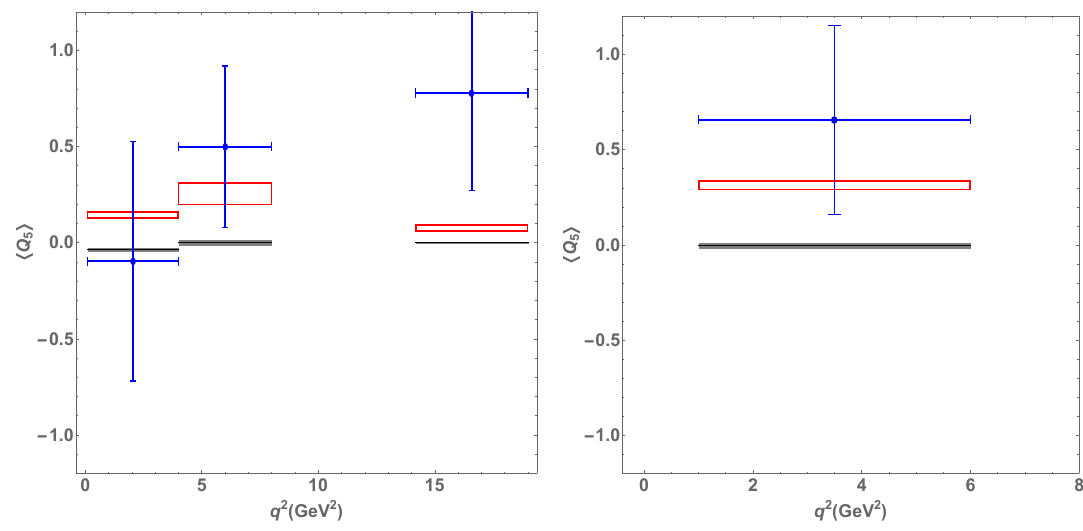
Figure 4 . Predictions for Q 5 in SM [11] (black lines) and in presence of NP (red boxes) in C (cid:22) = (cid:0) 1 : 1 (with C e = 0) and data from Belle [10] (blue crosses). 9 9 discrepancy of 1 : 3 (cid:27) in the SM, reduced to 0 : 7 (cid:27) for a NP contribution C (cid:22) hand side of (cid:12)gure